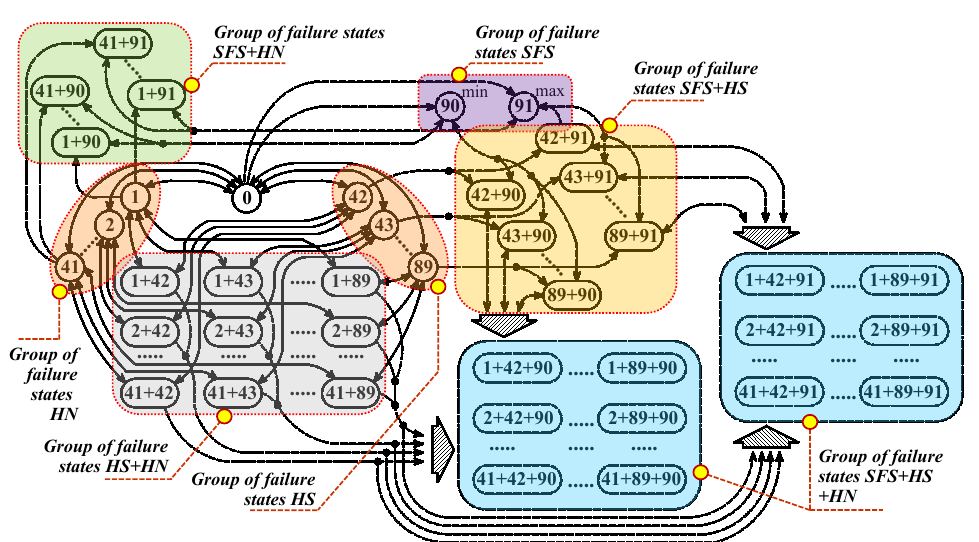
Fig. 7. Graph of the states of DHS in Shelekhov tacking into account the functioning of SFS (i.e. states corresponding to shortages of fuel supply to HS – 90 and 91). States of simultaneous failure of two components of HS and HN are indicated by their numbers with the “+” sign. States on the graph are grouped according to combinations: to the left of the fully operational state “0” there is a subset of failure states of HN components (from 1 to 41), to the right is a subset of failure states of HS components (from 42 to 89), their combinations are given below – complex states of simultaneous failures of HN and HS components. The structure of events described by the presented graph takes into account the functioning of SFS. A group of states corresponding to the so-called imitating components (IC) with numbers 90 and 91 (Fig. 7), failures of which correspond to fuel shortages calculating by the statistical modelling of SFS, are integrated in the set of failures states of DHS components. Failure of each of these two IC leads to an interruption of heat energy output from HS in accordance with the minimum and maximum levels of fuel shortages (90-min and 91-max in Fig. 7) with intensity (rate) of transitions to these states which are set based on one failure for the heating period, which corresponds to the conditions for earlier assessing of fuel shortages in HS. So, the considered sates of failures of IC are compatible with failure states of any components of HS and HN. Subsets of these states are presented on the graph as aggregated groups corresponding to the joint failures of IC and components of HS, HN, as well as combinations of